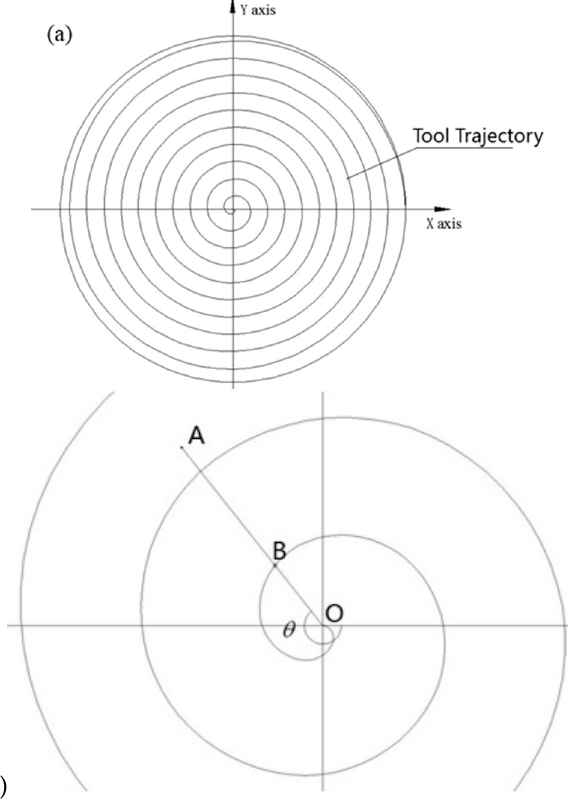
Figure 4. ( a ) Diamond tool trajectory of single point diamond turning (SPDT) on workpiece surface ( b ) Enlarged top view.